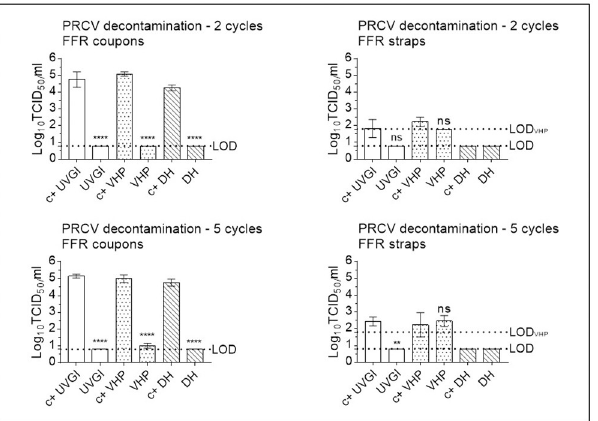
Fig 8. Porcine coronavirus (PRCV) inactivation following multiple cycle filtering facepiece respirator (FFR) decontamination using dry heat (DH), vaporised hydrogen peroxide (VHP), and ultraviolet germicidal irradiation (UVGI). Titrations were performed after two or five (three in the case of DH) decontamination treatments on PRCV-inoculated FFR coupons and straps. PRCV infectivity was analysed in swine testicular cells. The cell culture limit of detection (LOD) was 0.80 log10 TCID 50 /mL (6.31 × 10 0 TCID 50 /mL) for all analyses except those concerning VHP-treated FFR straps (1.80 log10 TCID 50 /mL (6.31 × 10 1 TCID 50 /mL)). Per decontamination method, nine PRCV- inoculated, decontaminated coupons (n = 9) and three inoculated, decontaminated straps (n = 3) were analysed in parallel to inoculated, untreated, positive control (c+) coupons (n = 9) and straps (n = 3). Mean log10 TCID 50 /mL and standard errors of the means are represented. P-values were computed by using a two-sided independent sample t-test, where ���� P < 0.0001, ��� P < 0.001, �� P < 0.01, � P < 0.05, and ns is P � 0.05. detection (LOD) was 0.80 log TCID /mL for all assays except for those concerning VHP- 10 50 treated SM- or FFR straps and UVGI-treated FFR straps (1.80 log TCID /mL). Comparable 10 50 high levels of infectious virus were recovered from once-, twice- (DH-treated FFRs) or four- times treated, MuNoV-inoculated left, right and middle coupons of all SMs and FFRs within a range of 4.55 ( ± 0.60) to 5.38 ( ± 0.25) log TCID /mL (S2 Fig). Recovery values for infectious 10 50